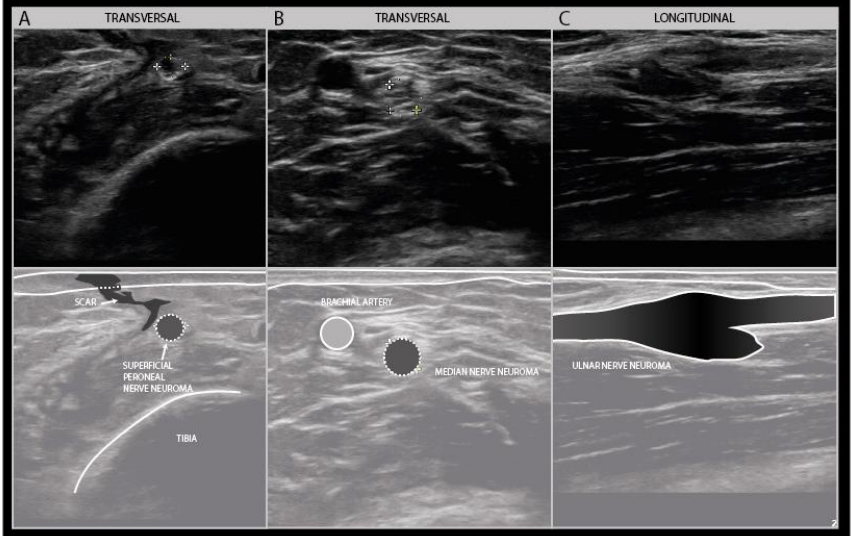
Figure 14. Examples of traumatic neuroma in continuity. Transverse view of a small superficial peroneal nerve neuroma following a motorbike injury ( A ). Transverse view of a median nerve traction neuroma from a distal elbow injury ( B ). Longitudinal view of a large disorganized ulnar neuroma from grenade shard injury to the forerarm ( C ).